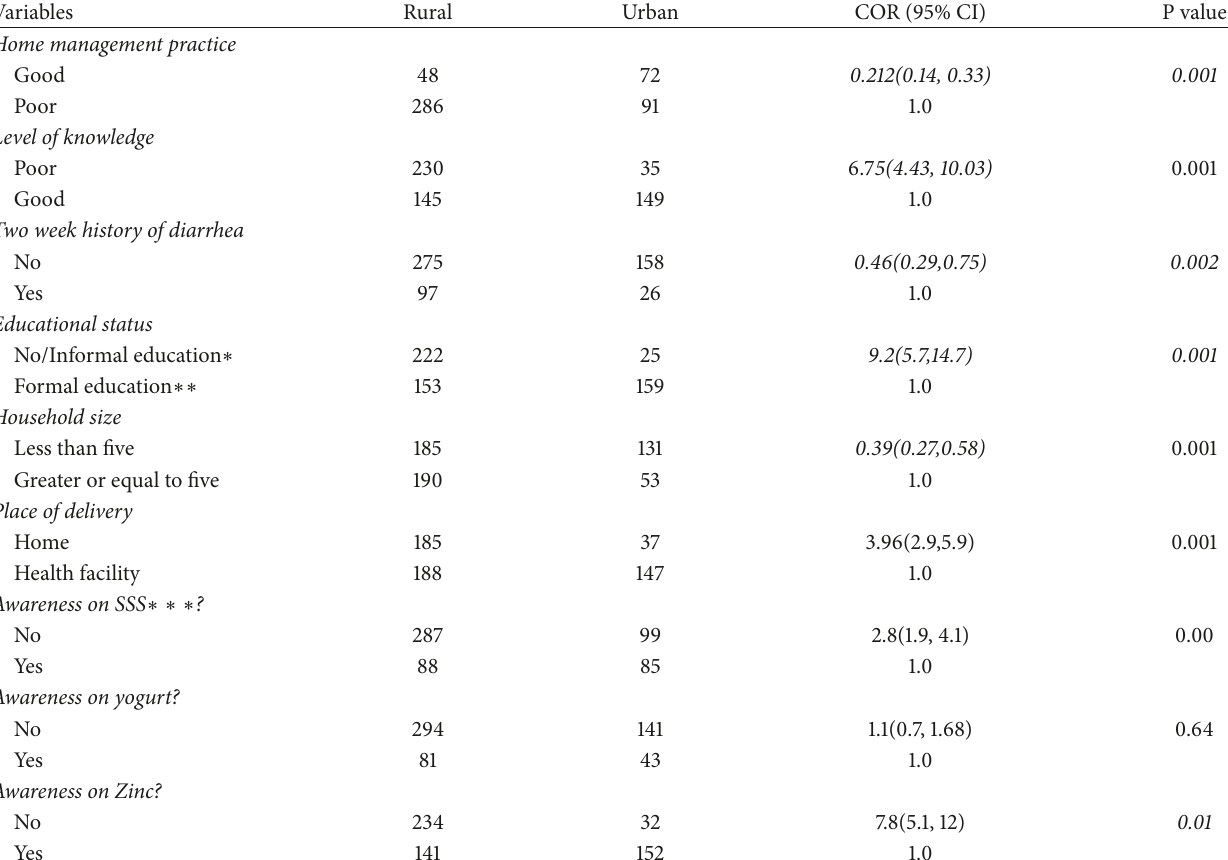
Table6:Anassociationbetweenresidenceandselectedhealthrelatedfactorsamongcaregiversofunder-fivechildren’sDobaworeda,Oromia,